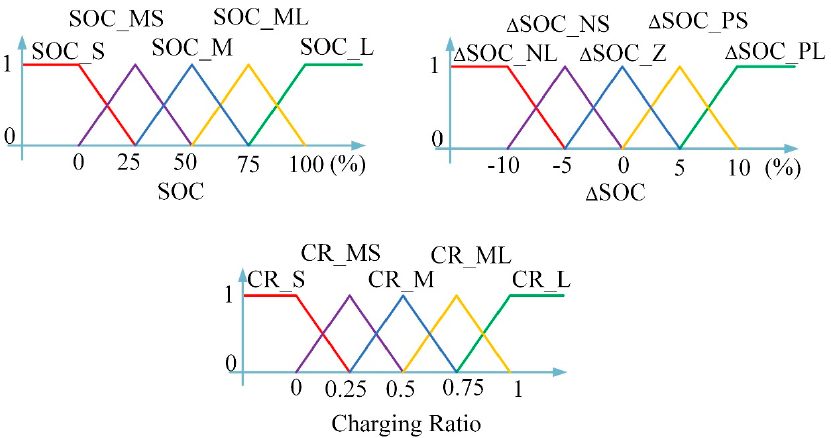
Figure 4. Input MFs (state ‐ of ‐ charge (SOC) and variation of SOC( ∆ SOC)) as well as the output MF